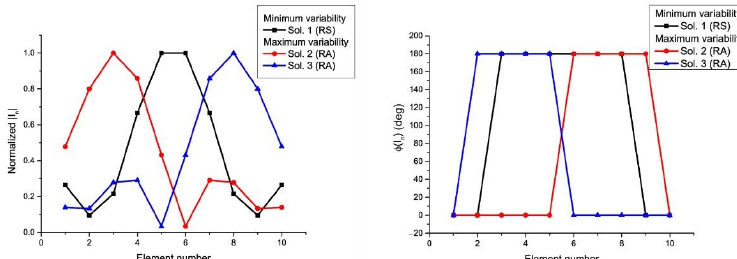
Figure 6. Magnitudes ( left ) and phases ( right ) of the current excitations with maximum and minimum variability linked to the solutions of the synthesis in the RPC of the 10-element linear array. The numbering of the solution agrees with 1—RS; 2—RA; and 3—RA. 2 and 3 are mirror images of each other.